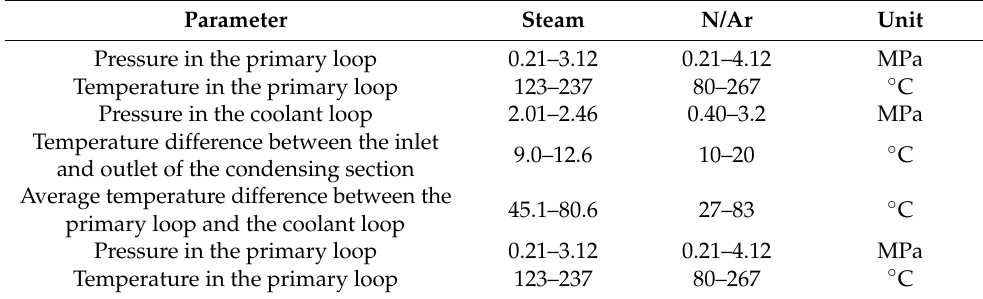
Table 8. The test conditions during experiments during pure steam condensation and steam conden- sation with